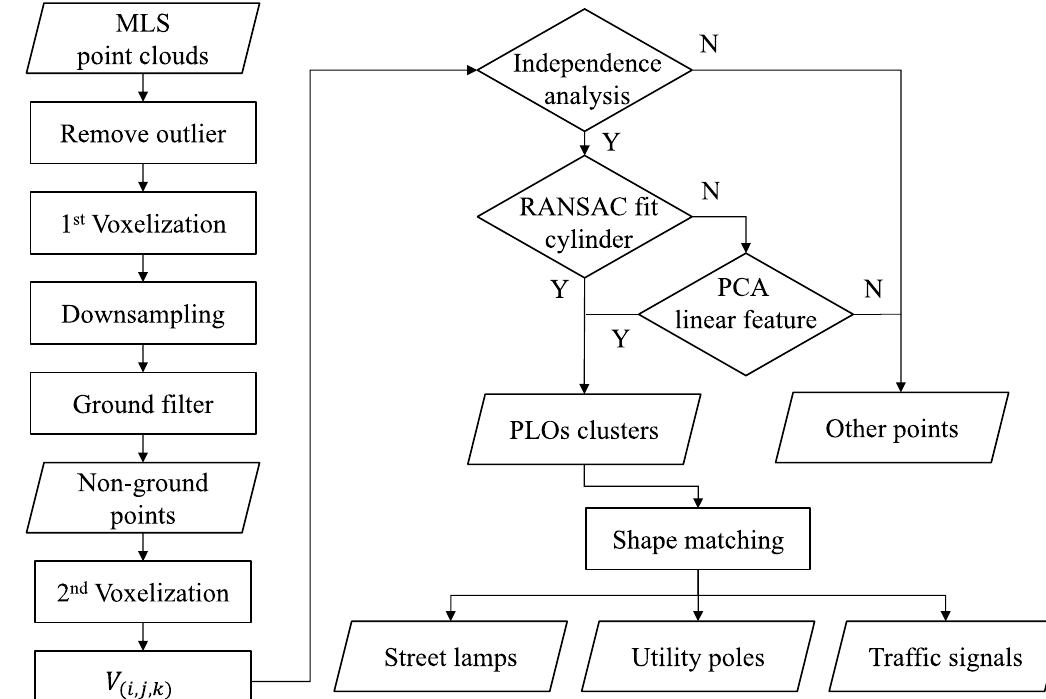
Figure 1. Flow chart of pole-like object (PLO) recognition.